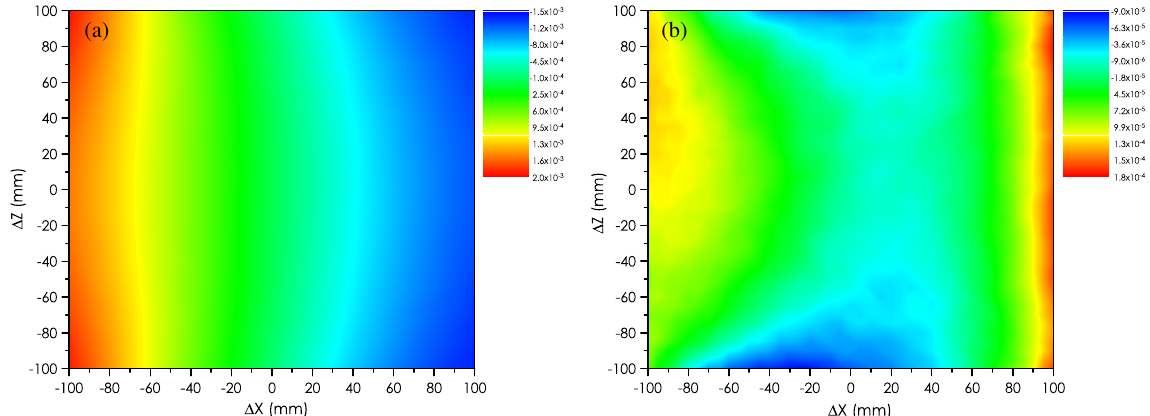
FIG. 15. Uniformity of the BL products, (cid:1) B z L=B z L , of the dipole field for the large-aperture magnet (a) before and (b) after corrections.